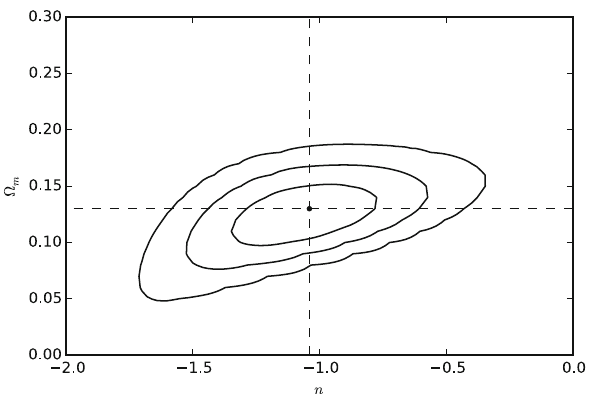
= 67 . 3 ± Fig. 8 The likelihood contour without marginalization of the parame- 0 ters,wherethebest-fitpairsare ( n , H D ( 0 . 13 , 67 ) , and ( n ,Ω D 0